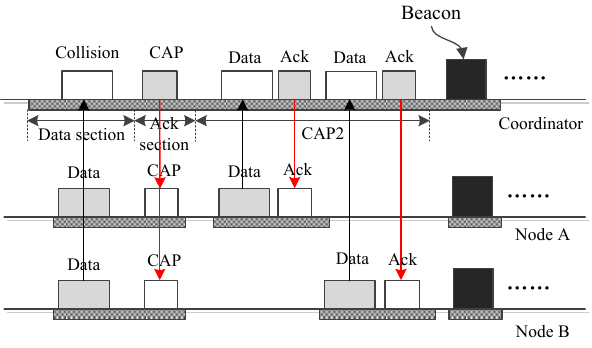
Figure 7. Two nodes send data to the